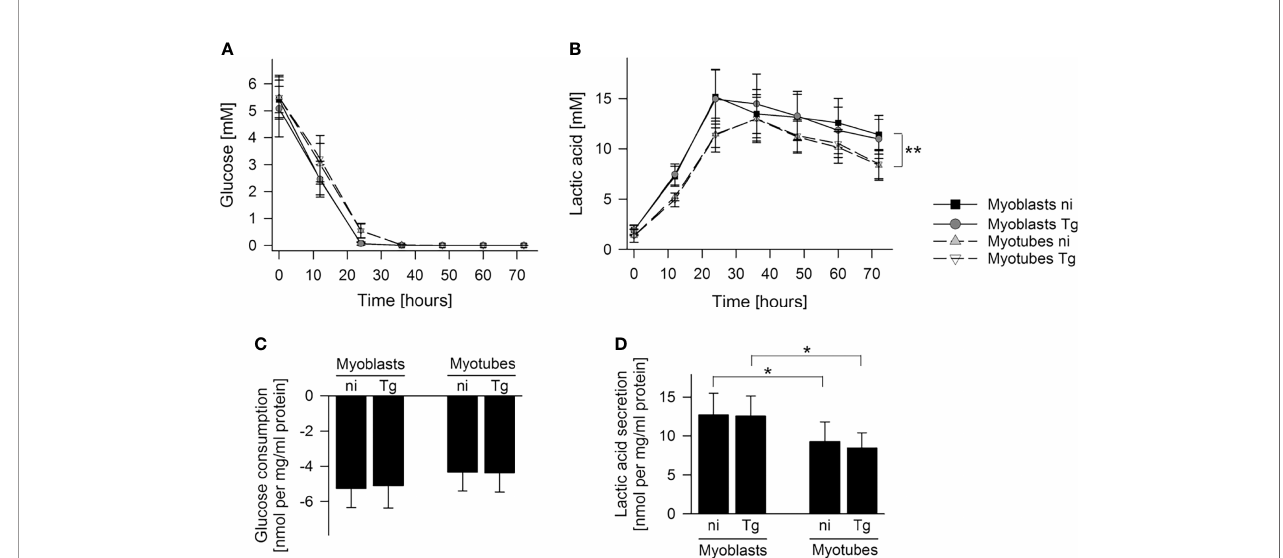
FIGURE 2 | Myoblasts maintain a higher lactic acid secretion rate than myotubes. C2C12 myoblasts and in vitro -differentiated C2C12 myotubes were infected with T. gondii or were left non-infected. Cell culture supernatants were collected at time points as indicated and metabolites were pro fi led by GC-MS. (A, B) Glucose and lactic acid concentrations were determined in cell culture supernatants of non-infected (ni) and T. gondii- infected (Tg) myoblasts and myotubes between 0 and 72 hours of infection. Data are means ± S.E.M. from three independent experiments; signi fi cant differences were identi fi ed by ANOVA (** p < 0.01). (C, D) Glucose consumption and lactic acid secretion were calculated during the initial 24 hours of infection and were normalized to total protein. Results are means ± S.E.M. from three independent experiments. Signi fi cant differences were identi fi ed by Student ’ s t -test (* p <